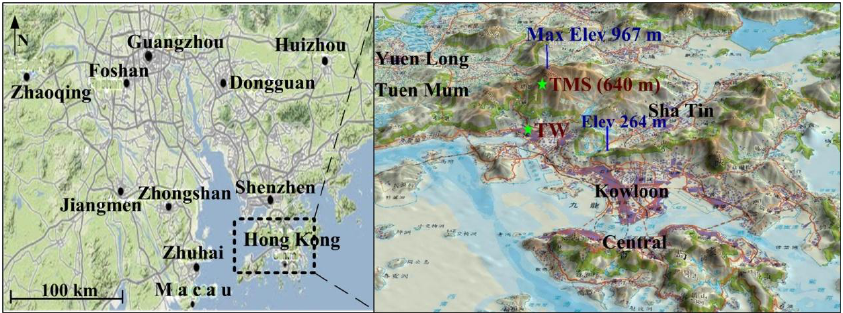
Fig. 1. The sampling sites and the surrounding environment.